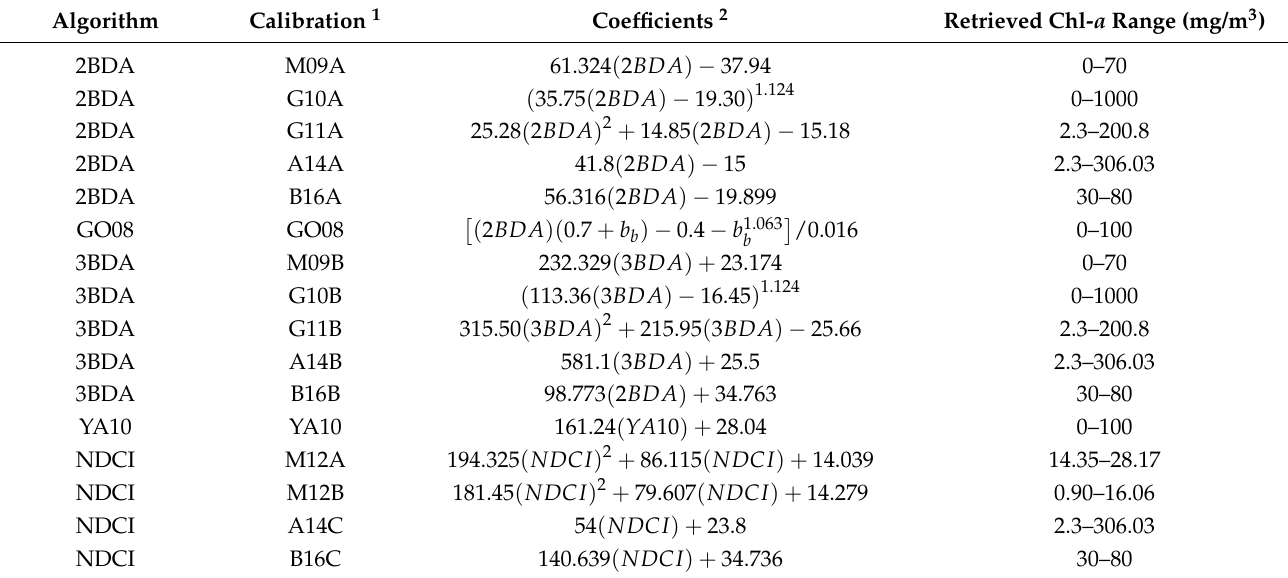
Table 3. List of the calibrations used for the chl- a